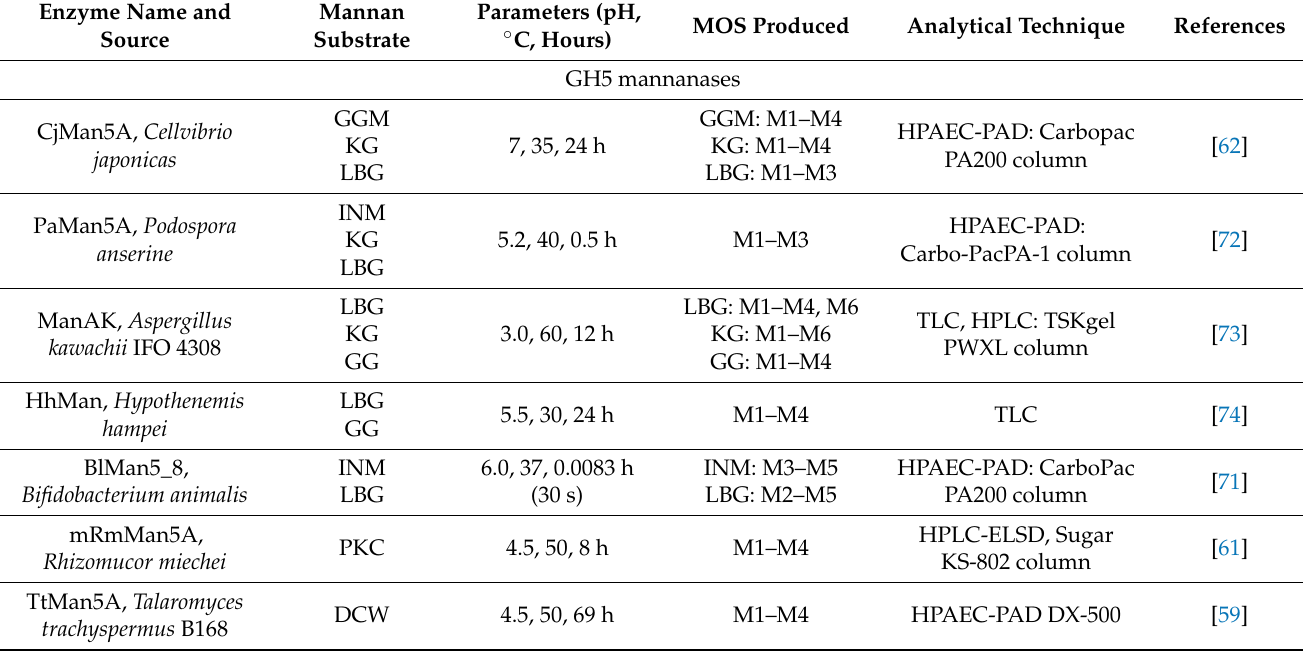
Table 2. Production of MOS by mannanases from various mannan and mannan-containing agricultural